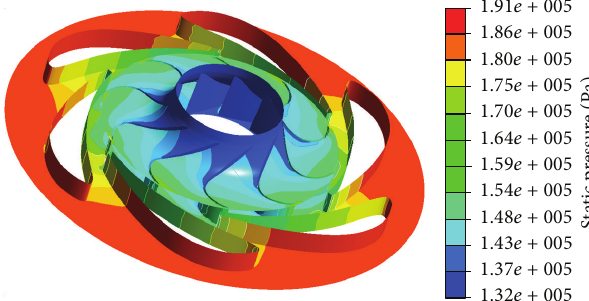
Figure 9: Static pressure contours at operating point (BEP) over the vanes and runner